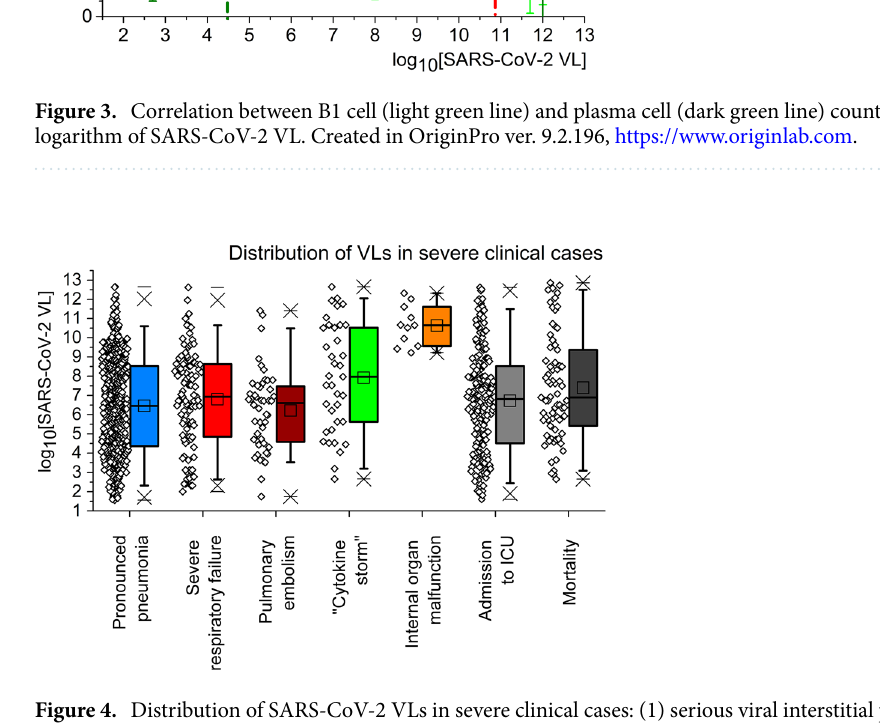
severest COVID-19 patients.